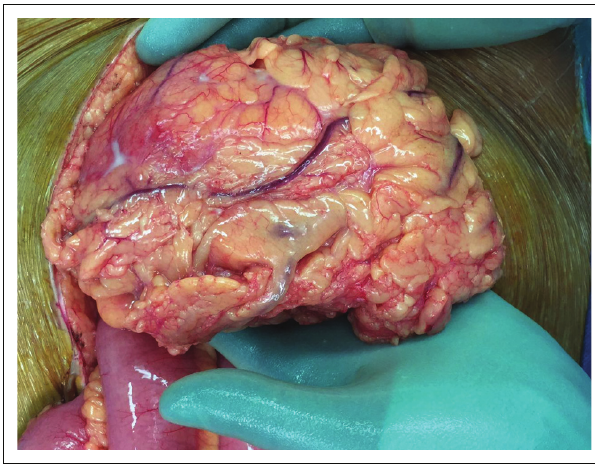
Source : Intra-operative picture of actual patient captured by S. Mewa Kinoo FIGURE 3: Intra-operative picture of the omental ‘wrap’ involving the caecum and ascending colon.